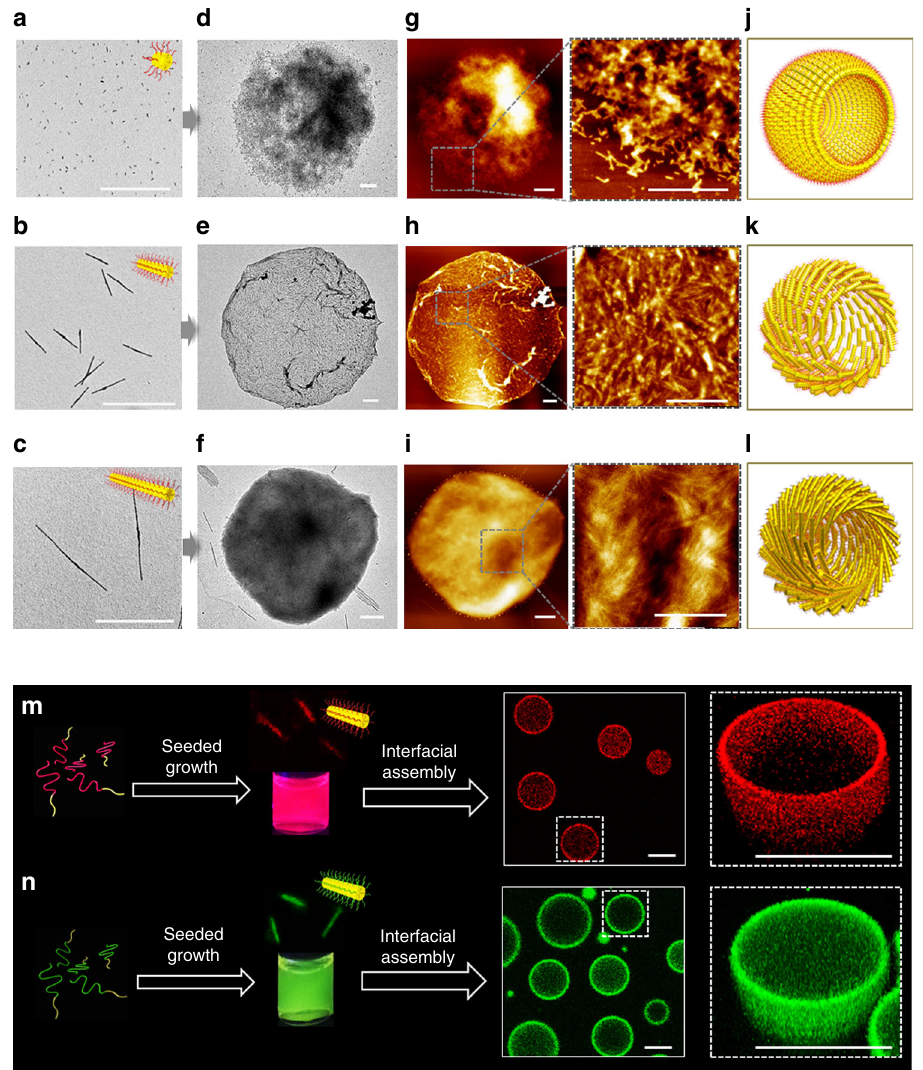
Fig. 2 Interfacial self-assembly of size-speci fi c supramolecular building blocks into Pickering emulsions. a – c TEM images showing building blocks based on 43 nm-sized micellar seeds ( L n = 43 nm, L w / L n = 1.05) ( a ), and 320 ( L n = 320 nm, L w / L n = 1.06) ( b ) or 1129 nm-long ( L n = 1129 nm, L w / L n = 1.02) ( c ) cylindrical micelles. Insets depict the crystalline PFS core ( yellow ) and disordered PMVSCOOH corona ( red ). d – f Corresponding TEM images of air-dried water-in-EHOH Pickering emulsion droplets prepared from the building blocks shown in a – c ; in each case an intact non-crosslinked membrane of closely packed BCP1 micelles is assembled at the oil/water droplet interface. Note the different membrane textures and alignment of the 320 and 1129 nm-long micelles parallel to the membrane surface. g – i Pairs of large area and corresponding high-resolution AFM images showing membrane textures associated with the microstructures presented in d – f . Dashed lines and boxes indicate areas selected for high-magni fi cation imaging. j – l Corresponding graphical representations. m , n Preparation of fl uorescent Pickering emulsions based on BCP1 seed-mediated CDSA of mixtures of BCP1 and fl uorescently labelled BCP2 ( m ) or BCP3 ( n ) unimers. Interfacial assembly of the doped cylindrical building blocks ( L n = 756 nm and L w / L n = 1.02 for red cylinders, L n = 789 nm and L w / L n = 1.02 for green cylinders) in EHOH/water mixtures gives rise to intact hollow spheroids with red or green fl uorescent membranes as shown by the confocal fl uorescence microscopy images recorded under UV irradiation at 365 nm. Corresponding Z -stack images of the microcapsules identi fi ed by the dashed boxes are shown on the far right . The fl uorescent cylinders were taken from separate regions of the CLSM images. Scale bars in a – l , 1 µ m. Scale bars in m and n , 5 µ